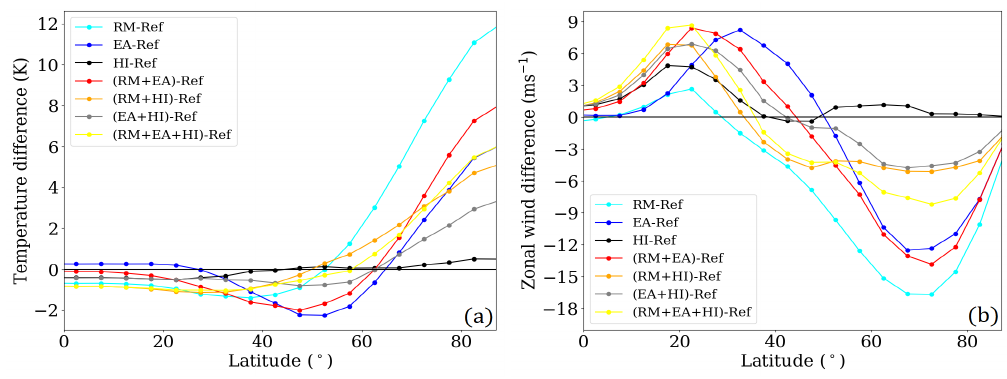
Figure 3. Zonal mean temperature differences ( a ) and zonal wind differences ( b ) between the single GW hotspots, the doubled GW hotspots and the tripled GW hotspots and the Ref simulation averaged between 18 and